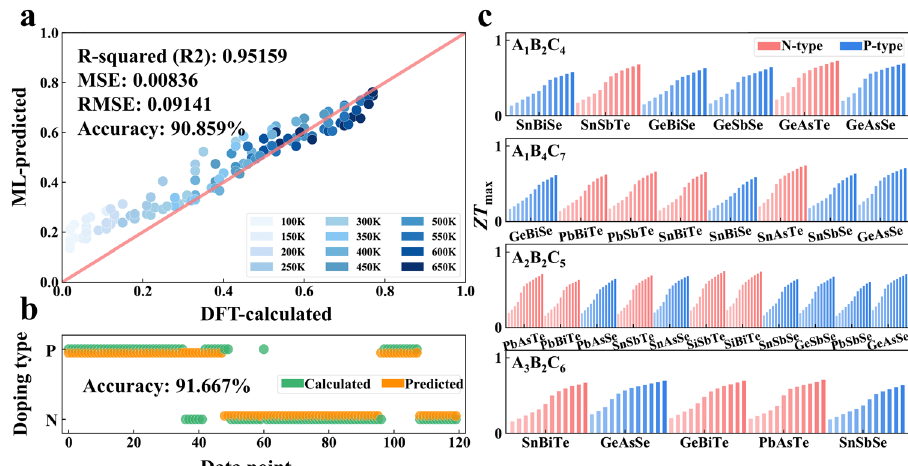
Fig. 3 ML models validation and thermoelectric performance prediction. ML-predicted and DFT-calculated a ZT max and b corresponding doping type of 10 compounds at different temperatures (120 data points). c ML-predicted ZT max and optimal doping type at 12 temperatures (from 100 to 650 K with an interval of 50 K) for the remaining 30